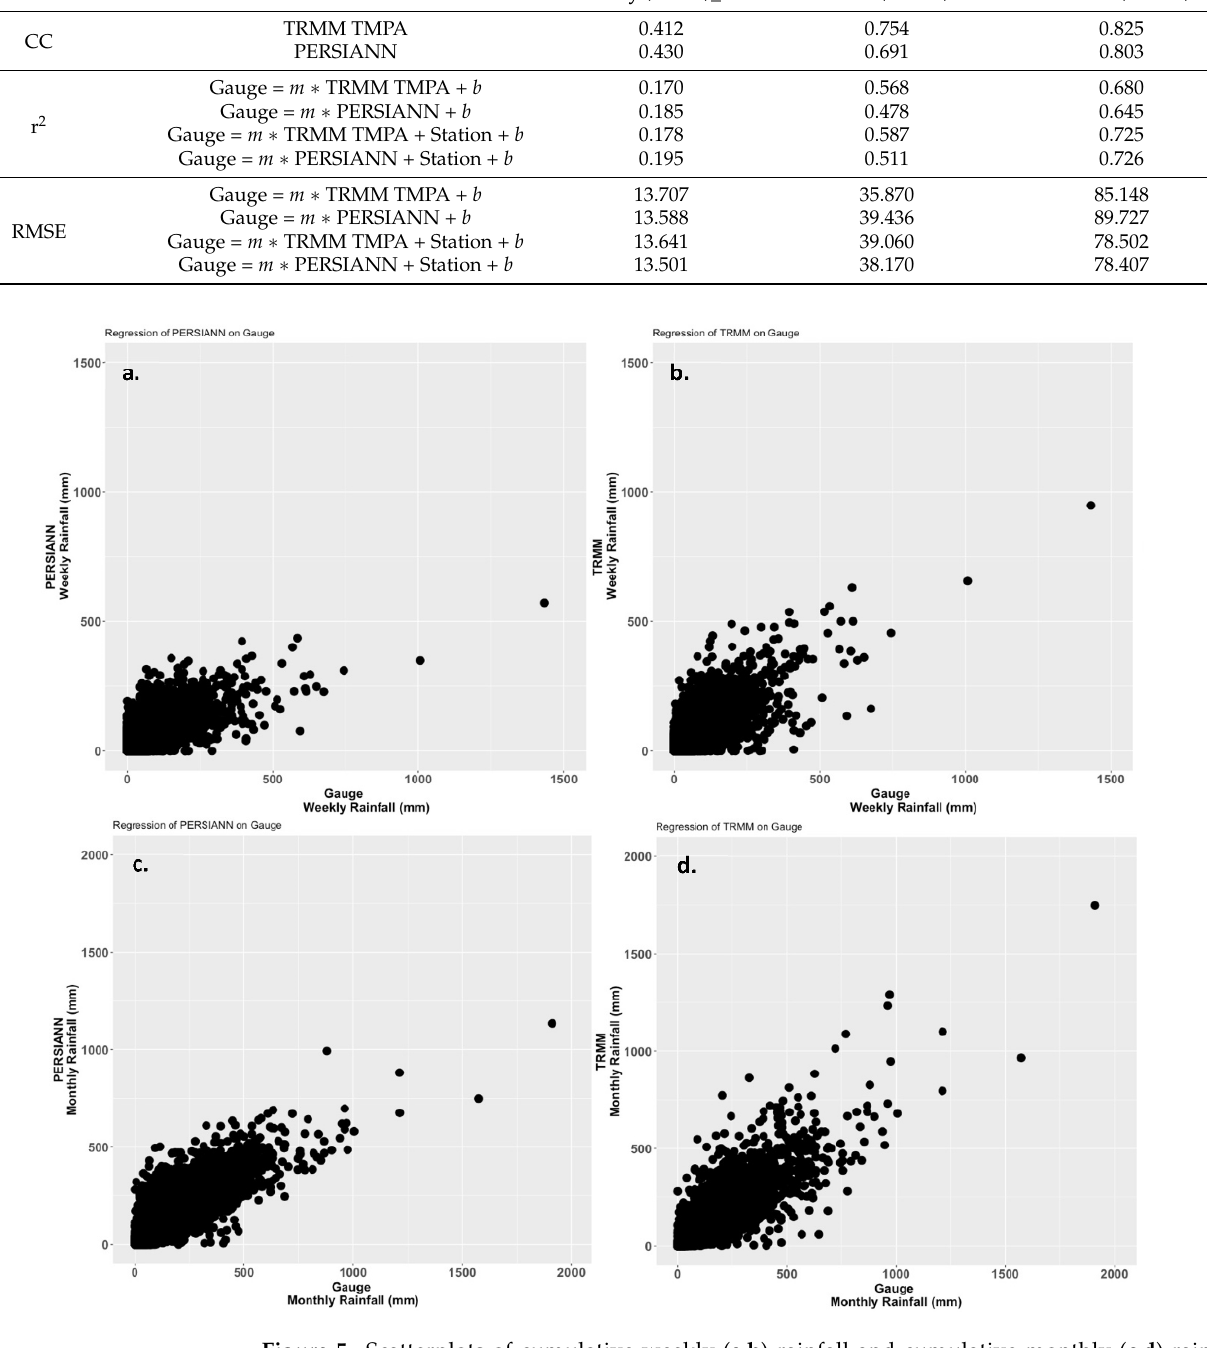
Figure 5. Scatterplots of cumulative weekly ( a , b ) rainfall and cumulative monthly ( c , d ) rainfall between in situ rain gauges and satellite estimates for PERSIANN ( a , c ) and TRMM TMPA ( b , d ). For example, an in situ gauge measured almost 1500 mm, while the TRMM TMPA pixel estimated 1000 mm (see Figure 5b). However, TRMM TMPA did estimate closer to the in situ rainfall than PERSIANN, as indicated on the